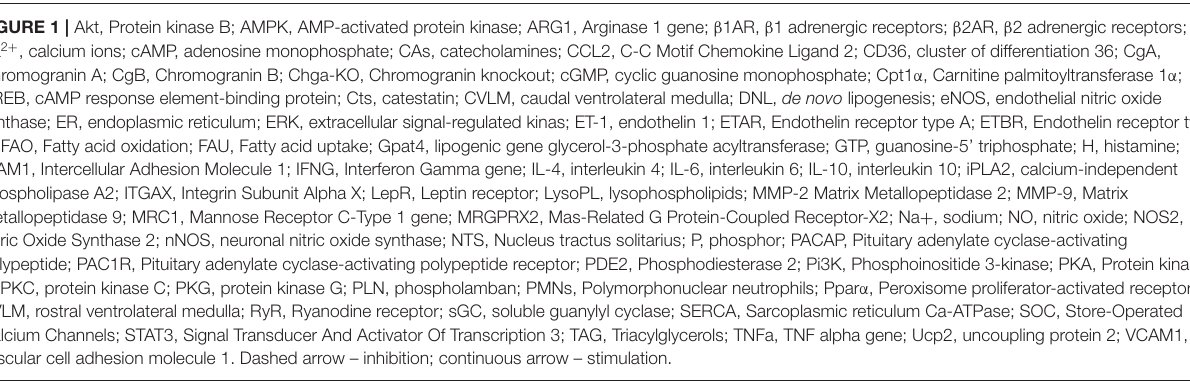
FIGURE 1 | Akt, Protein kinase B; AMPK, AMP-activated protein kinase; ARG1, Arginase 1 gene; β 1AR, β 1 adrenergic receptors; β 2AR, β 2 adrenergic receptors; Ca 2 + , calcium ions; cAMP, adenosine monophosphate; CAs, catecholamines; CCL2, C-C Motif Chemokine Ligand 2; CD36, cluster of differentiation 36; CgA, Chromogranin A; CgB, Chromogranin B; Chga-KO, Chromogranin knockout; cGMP, cyclic guanosine monophosphate; Cpt1 α , Carnitine palmitoyltransferase 1 α ; CREB, cAMP response element-binding protein; Cts, catestatin; CVLM, caudal ventrolateral medulla; DNL, de novo lipogenesis; eNOS, endothelial nitric oxide synthase; ER, endoplasmic reticulum; ERK, extracellular signal-regulated kinas; ET-1, endothelin 1; ETAR, Endothelin receptor type A; ETBR, Endothelin receptor type B; FAO, Fatty acid oxidation; FAU, Fatty acid uptake; Gpat4, lipogenic gene glycerol-3-phosphate acyltransferase; GTP, guanosine-5’ triphosphate; H, histamine; ICAM1, Intercellular Adhesion Molecule 1; IFNG, Interferon Gamma gene; IL-4, interleukin 4; IL-6, interleukin 6; IL-10, interleukin 10; iPLA2, calcium-independent phospholipase A2; ITGAX, Integrin Subunit Alpha X; LepR, Leptin receptor; LysoPL, lysophospholipids; MMP-2 Matrix Metallopeptidase 2; MMP-9, Matrix metallopeptidase 9; MRC1, Mannose Receptor C-Type 1 gene; MRGPRX2, Mas-Related G Protein-Coupled Receptor-X2; Na + , sodium; NO, nitric oxide; NOS2, Nitric Oxide Synthase 2; nNOS, neuronal nitric oxide synthase; NTS, Nucleus tractus solitarius; P, phosphor; PACAP, Pituitary adenylate cyclase-activating polypeptide; PAC1R, Pituitary adenylate cyclase-activating polypeptide receptor; PDE2, Phosphodiesterase 2; Pi3K, Phosphoinositide 3-kinase; PKA, Protein kinase A; PKC, protein kinase C; PKG, protein kinase G; PLN, phospholamban; PMNs, Polymorphonuclear neutrophils; Ppar α , Peroxisome proliferator-activated receptor- α ; RVLM, rostral ventrolateral medulla; RyR, Ryanodine receptor; sGC, soluble guanylyl cyclase; SERCA, Sarcoplasmic reticulum Ca-ATPase; SOC, Store-Operated Calcium Channels; STAT3, Signal Transducer And Activator Of Transcription 3; TAG, Triacylglycerols; TNFa, TNF alpha gene; Ucp2, uncoupling protein 2; VCAM1, vascular cell adhesion molecule 1. Dashed arrow – inhibition; continuous arrow –